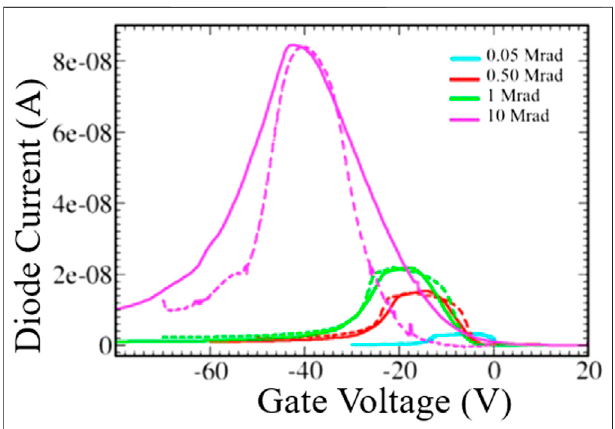
FIGURE 7 | I-V characteristics of n-on-p HPK gated-diode: comparison between the measured and simulated diode current as a function of gate voltage (with p-spray isolation